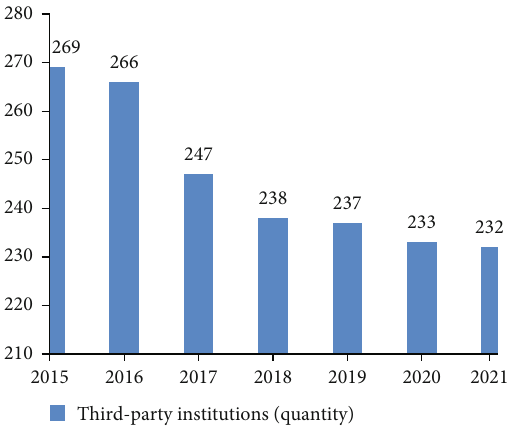
Figure 4: The quantity of China ’ s third-party payment institution from 2015 to September